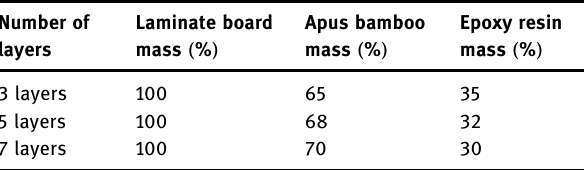
Table 3: Comparison of specimen mass fraction Number of